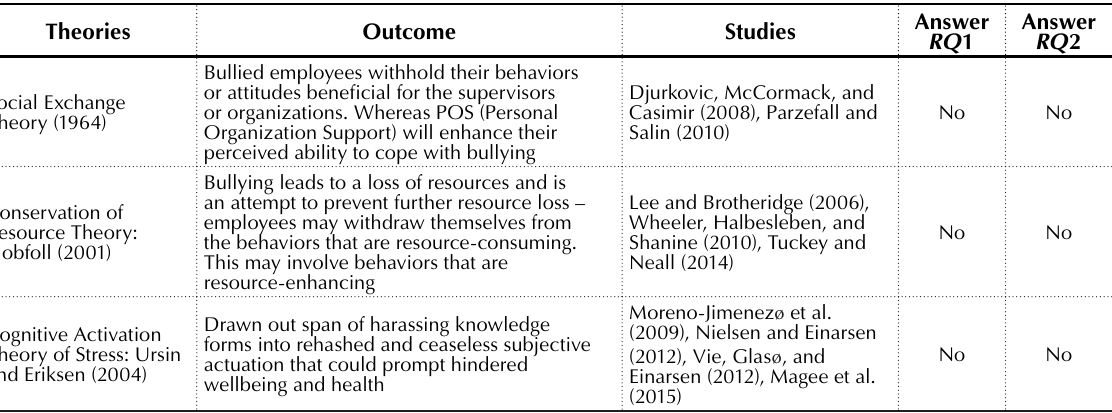
Table 2. Theories of WPB: the four Bullying-Outcome Relationship theories